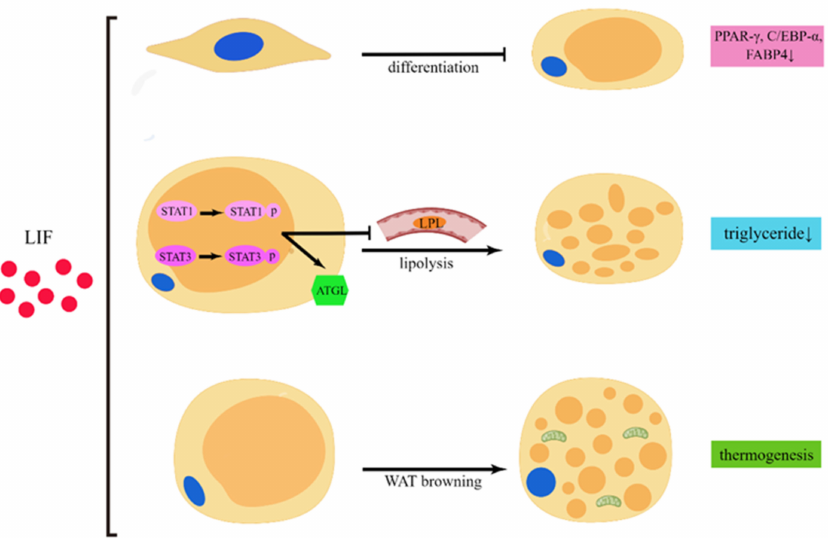
Figure 2. The role of LIF in adipocytes. LIF can activate the phosphorylation of STAT1 and STAT3, increase ATGL to lead to lipolysis, and is associated with decreased LPL activity. Finally, it results in triglyceride loss in adipocytes. LIF also can induce WAT browning, a thermogenic process. Meanwhile, LIF may inhibit preadipocytes’ differentiation to mature adipocytes, as evidenced by the inhibition of PPAR- γ , C/EBP- α , and FABP4 expression (by Figdraw “www.figdraw.com”, accessed on 5 May